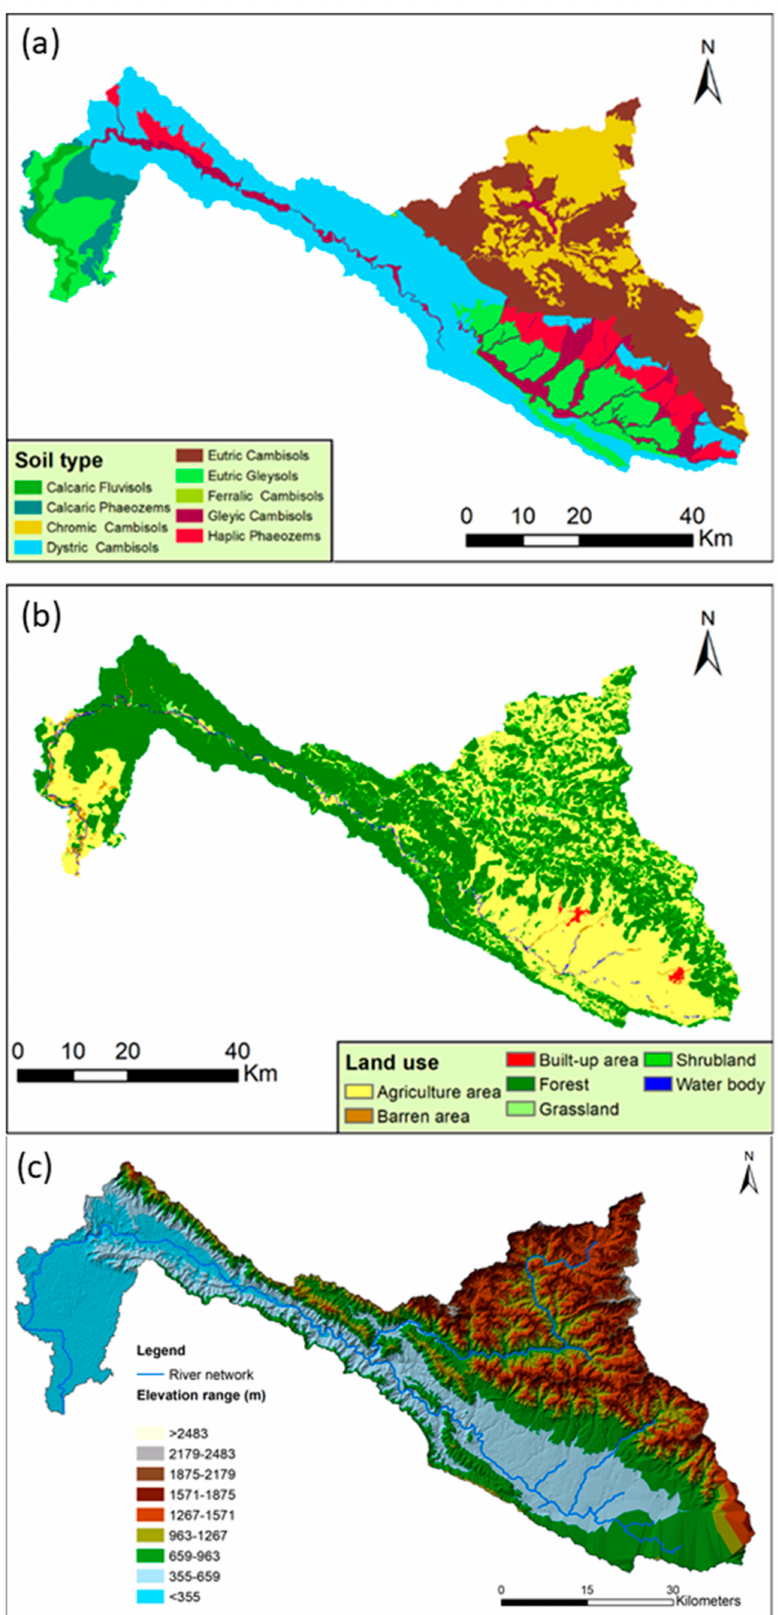
Figure 2. Soil type ( a ), land-use type ( b ) and elevation ( c ) maps of the Babai River